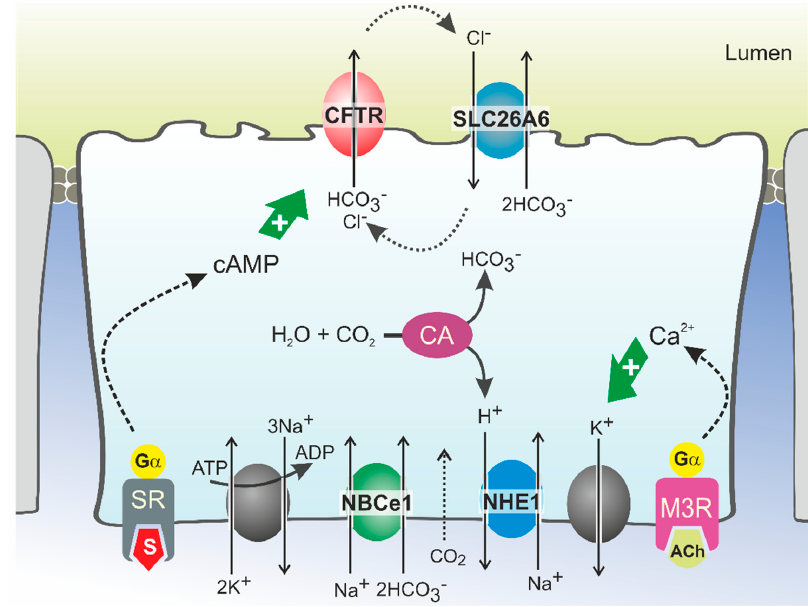
Figure 1. Model of HCO 3 − secretion in pancreatic ducts. HCO 3 − secretion is controlled by neuro- endocrine input, chiefly by secretin (S) and acetylcholine (ACh), which increase cellular cAMP and Ca 2+ levels, respectively, via stimulation of G protein-coupled receptors. This triggers Na + -coupled HCO 3 − uptake across the basolateral plasma membrane through NBCe1 and luminal HCO 3 − efflux through CFTR and SLC26A6. HCO 3 − may also be accumulated intracellularly via the coordinated activity of carbonic anhydrases (CA) and a proton extrusion mechanism, NHE1. Opening of K